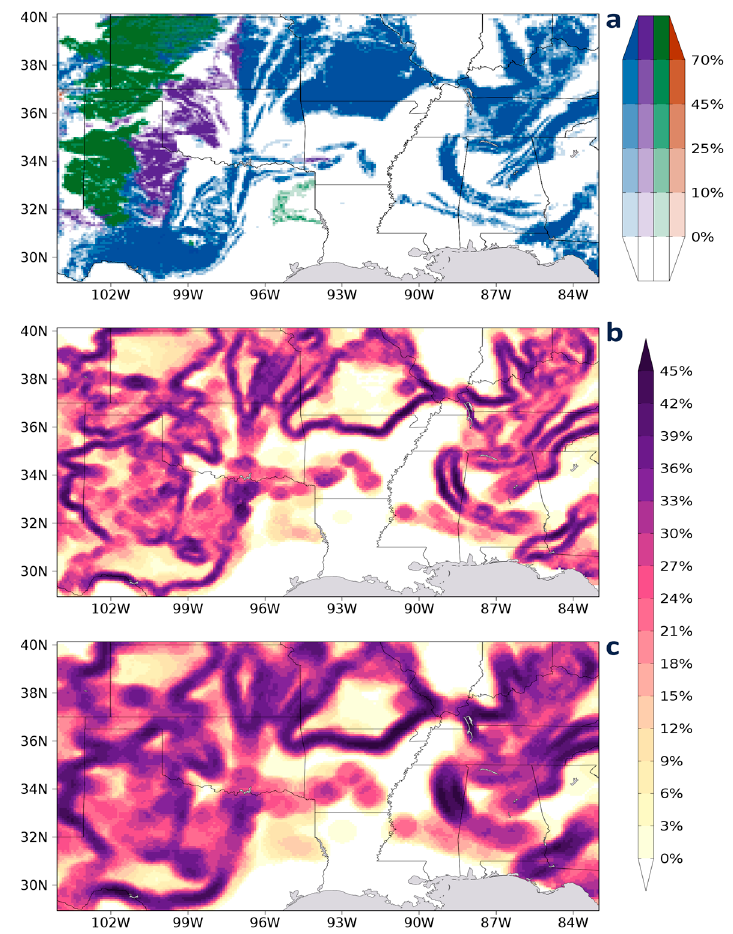
Figure 1. Domain of study showing: ( a ) distribution of shallow karst coverage in each 9 km grid cell; carbonates (blue), evaporates (green), unconsolidated pseudokarst (purple), volcanic (orange); spatial standard deviation of total karst coverage percentage within radii of ( b ) 0.3°; ( c ) 0.5°.